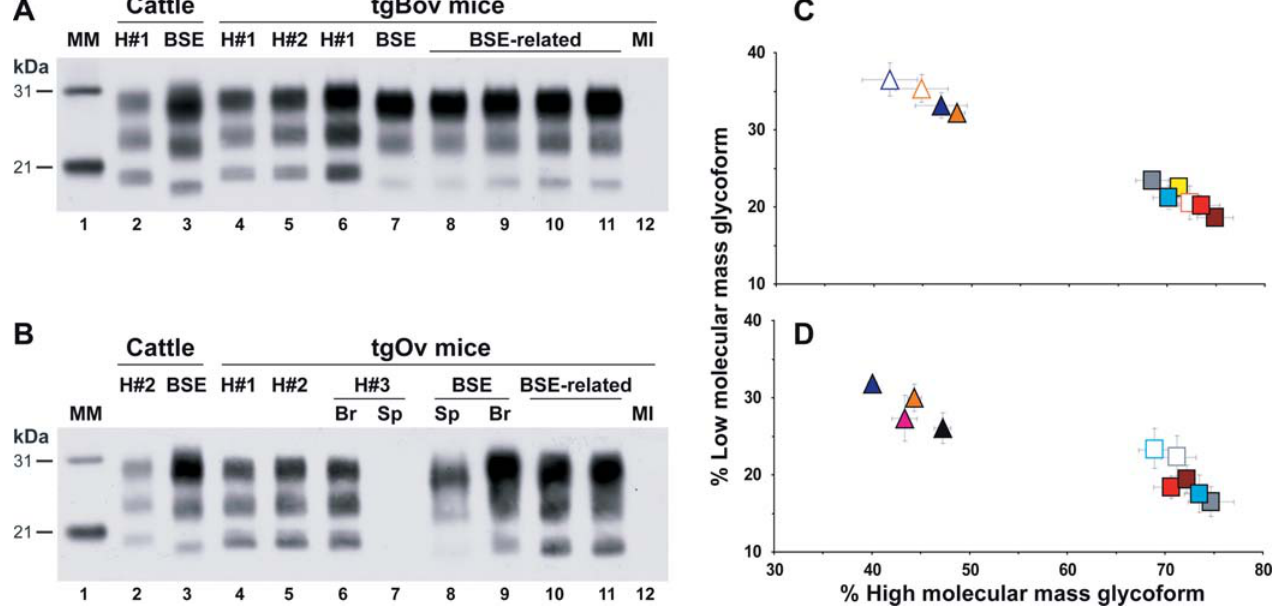
Figure 2. Western Blot Analysis of PrP res in the Brains of Transgenic Mice Infected with H-Type or BSE-Type Agents (A) Primary or secondary (lane 6) transmission to tgBov mice. BSE-type inocula include cattle BSE no. 3 (lanes 3 and 7), sheep BSE ARQ no. 1 and ARR no. 1 (lanes 8 and 9), goat BSE (lane 10), and vCJD (lane 11). The PrP res profiles of both H-type and BSE agents in cattle (lanes 2 and 3) are essentially similar to those in tgBov mice (lanes 4–11). Brain tissue equivalent loaded: 2.5 mg in lane 2; 0.15 mg in lane 3; 0.5 mg in lanes 4–12. MI, mock-infected brain; MM, molecular markers. (B) Primary transmission to tgOv mice. H-type agent shows a distinct PrP res pattern in the brain (Br) compared to BSE agents (lane 9, BSE no. 3; lane 10, goat BSE; lane 11, vCJD). Note the lack of PrP res signal in the spleen (Sp) of H-type–infected mice (lane 7), unlike that in BSE-infected mice (lane 8). Brain or spleen tissue equivalent loaded: 3 mg in lane 2; 0.15 mg in lane 3; 0.5 mg in lanes 4–6; 2 mg in lanes 7–12. (C and D) Ratio of high- and low-molecular-mass PrP res glycoforms in the brains of tgBov (C) and tgOv (D) mice following challenge with H-type or BSE agents (data plotted as means 6 SEM). H-type isolates are represented as triangles (no. 1, blue; no. 2, orange; no. 3, pink; and no. 5, black) and BSE agents as squares (BSE no. 3, red; sheep BSE ARQ no. 1, grey; sheep BSE ARR no. 1, yellow; goat BSE, brown; and vCJD, light blue). Secondary transmissions are represented by unfilled symbols of the same colour. Note the strikingly distinct glycoform ratio between H-type and BSE groups in both mouse lines, as reported in cattle [9]. DOI: